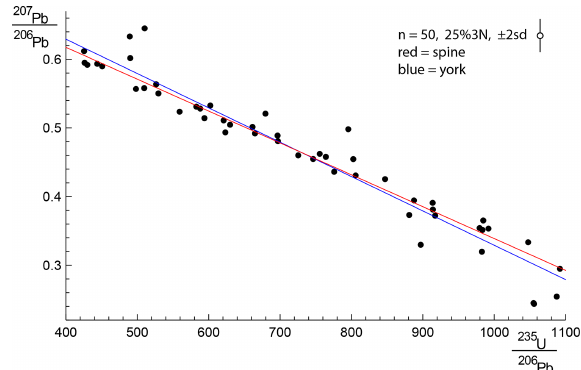
Figure E1. A 25%3N simulation with n = 50, with the SPINE fit in red and the YORK fit in blue. The 2 σ uncertainty applied to the y value of each data point is indicated in the top right of the figure. See text.